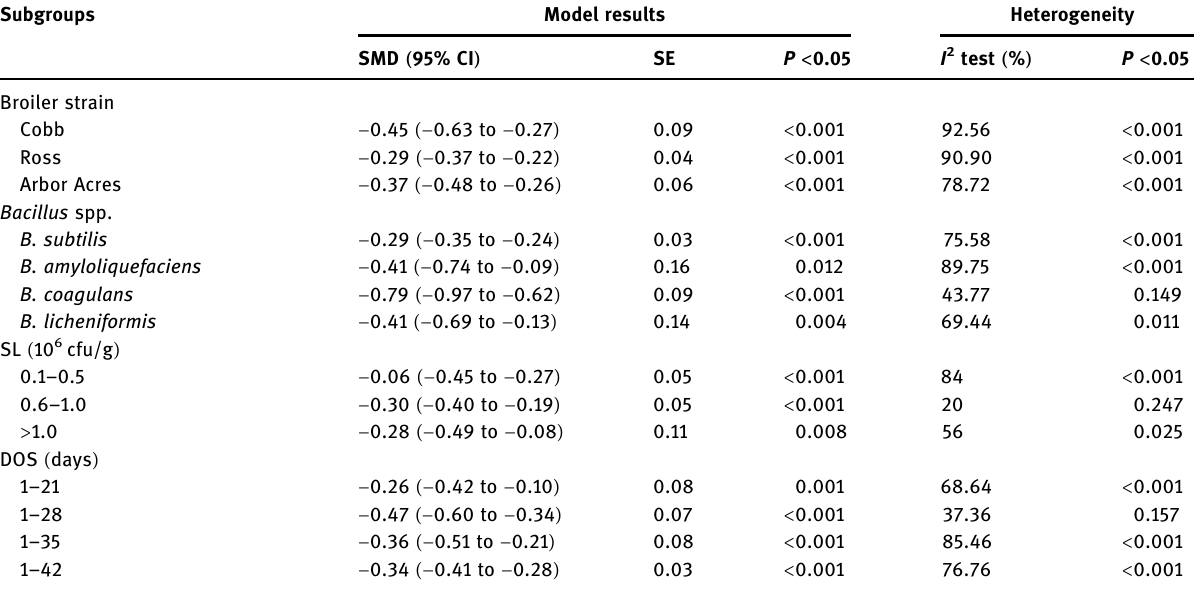
Table 3: Subgroup analysis of the e ff ect of Bacillus probiotics on FCE of broiler chickens